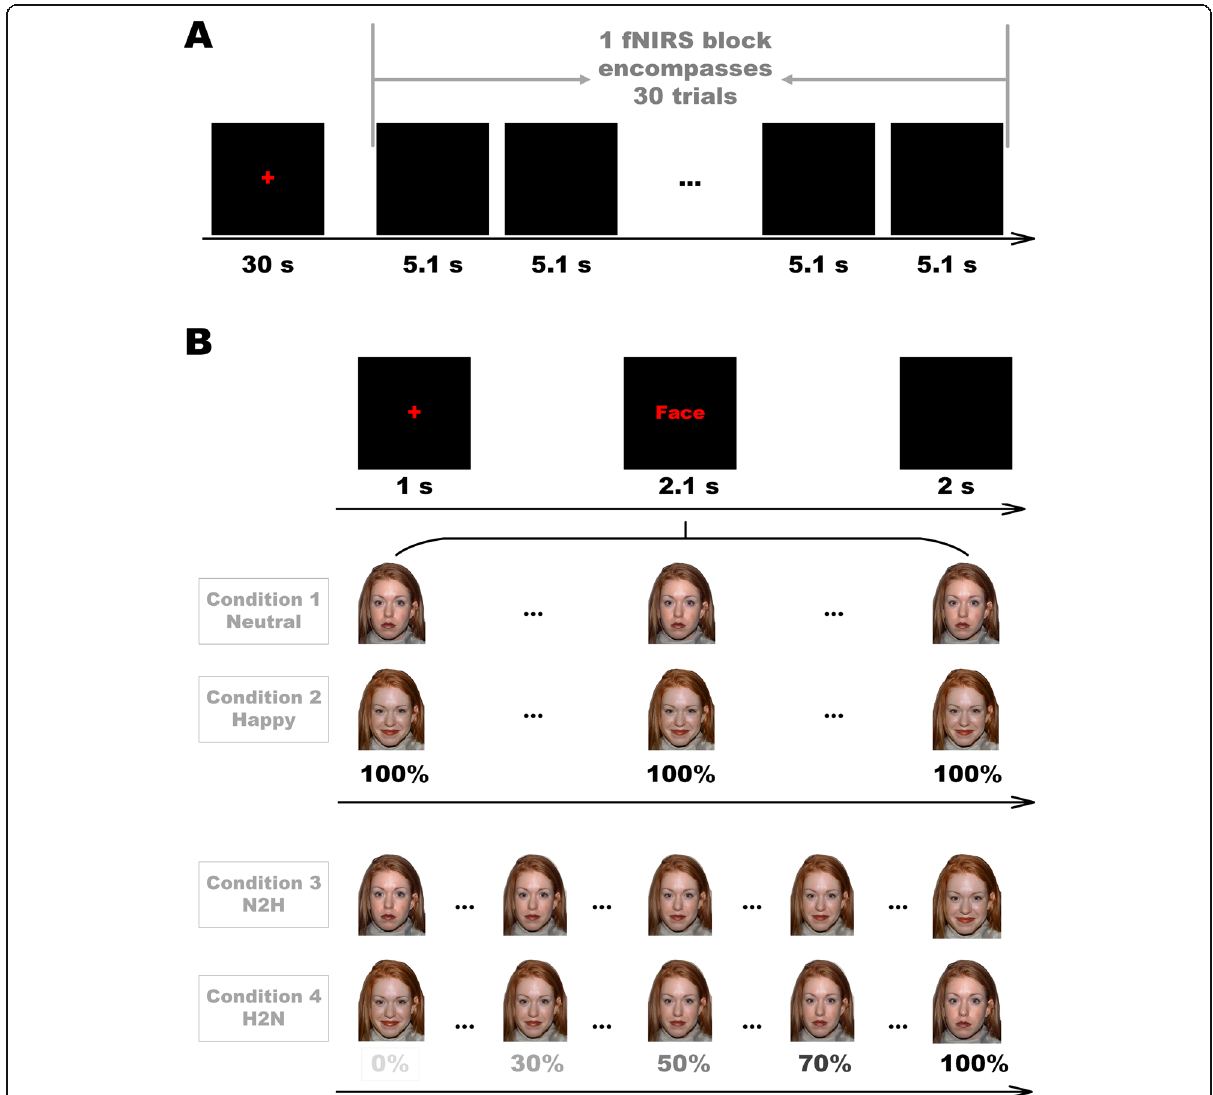
Fig. 1 The procedure of the experiment. a The illustration of one fNIRS block including 30 trials; b The schema of one example